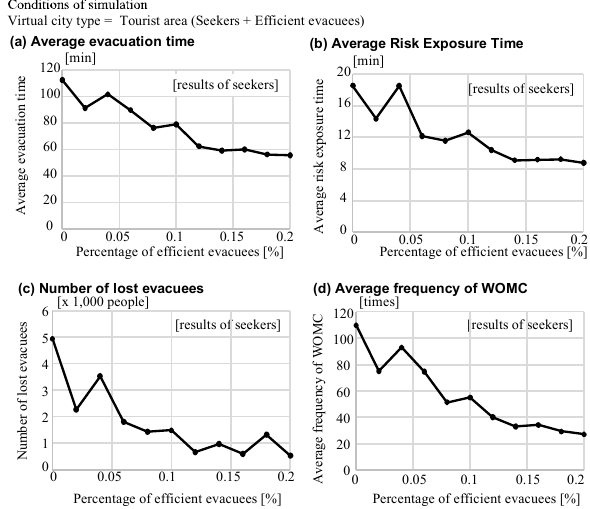
Figure 10. Effects of WOMC about the location of evacuation